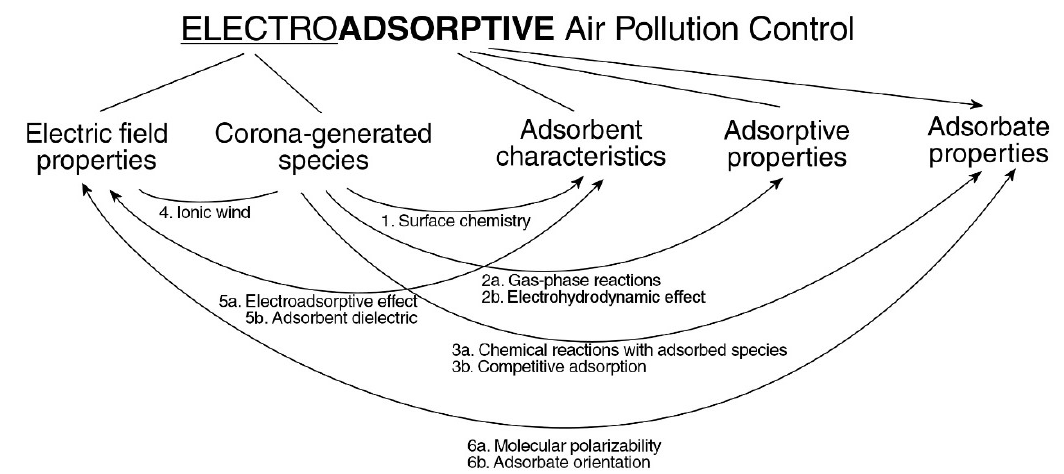
Figure 14. Diagram of the processes interacting within the electroadsorptive air pollution control technique.